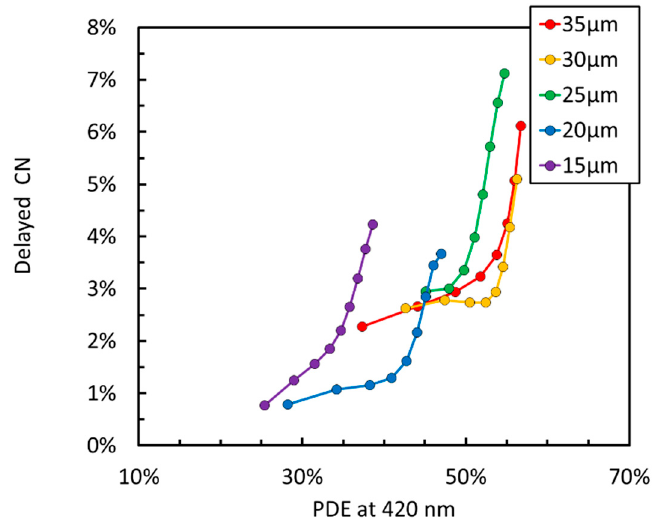
Figure 7. Delayed corrected noise (DeCN) as a function of PDE for the different cell sizes of the NUV-HD SiPMs (15 µm to 35 µm).